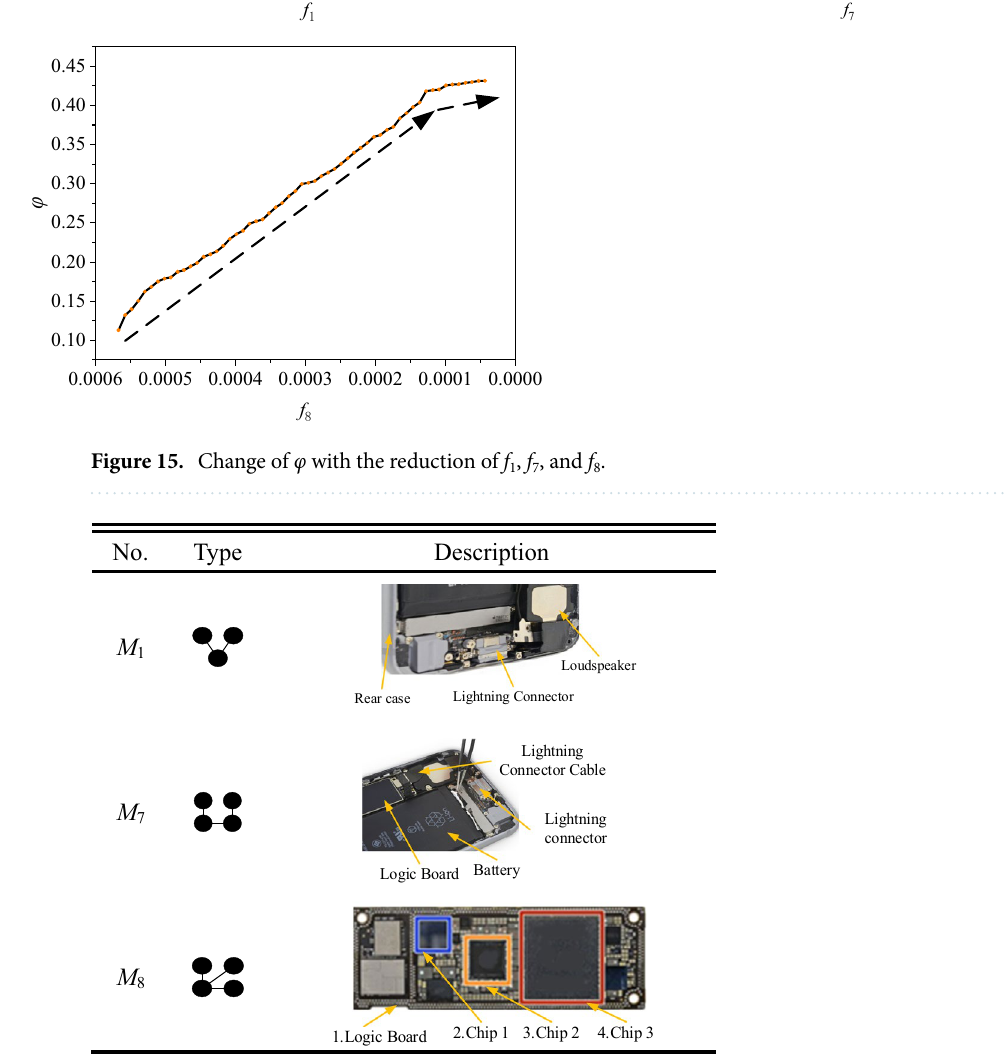
Table 9. Examples of eight kinds of (anti-) motifs (Adapted in part with free permission from iFixit, https:// www. ifixit. com/ Teard own/ iPhone/. Licenced under the CC BY open access licence).